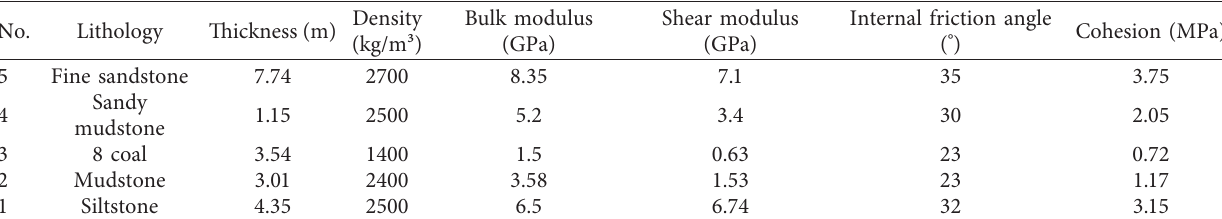
Figure 10: Numerical calculation model. Table 1: Mechanical parameters of the coal roof and